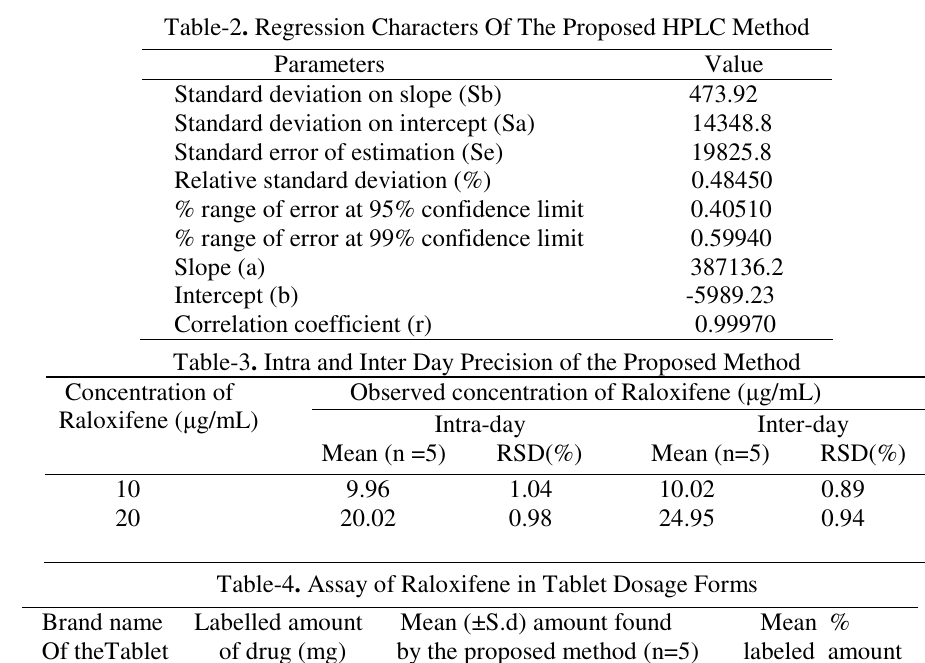
Table-4 . Assay of Raloxifene in Tablet Dosage Forms